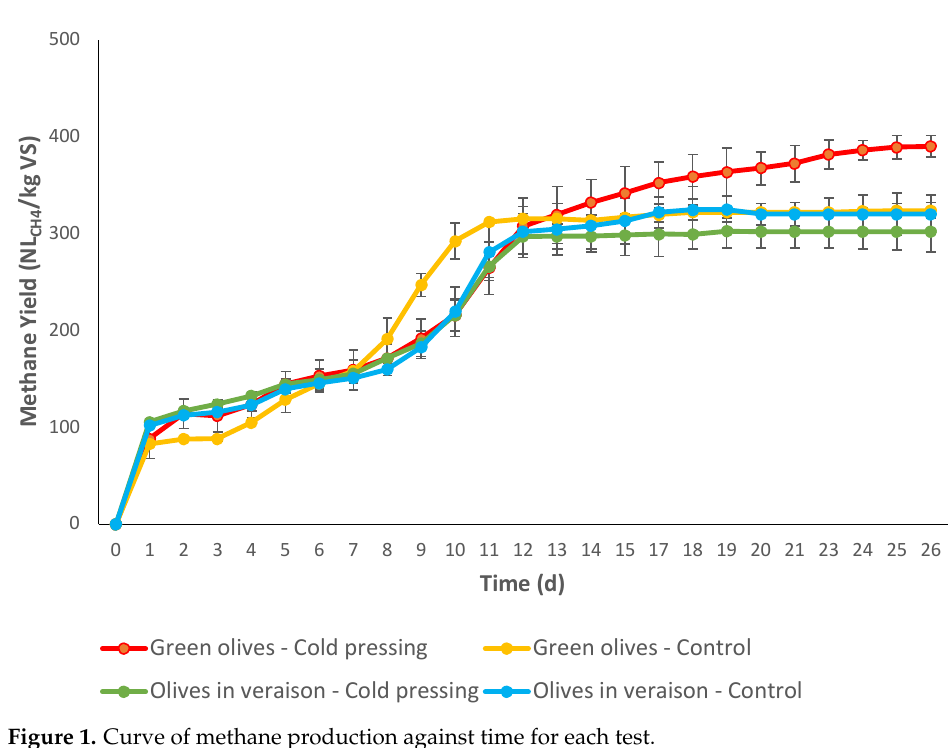
Figure 1. Curve of methane production against time for each test ( • green olives—cold pressing; • green olives—control; • olives in veraison—cold pressing; • olives in veraison—control). Tsigkou et al. [16] reported higher methane yield for raw three-phase olive mill